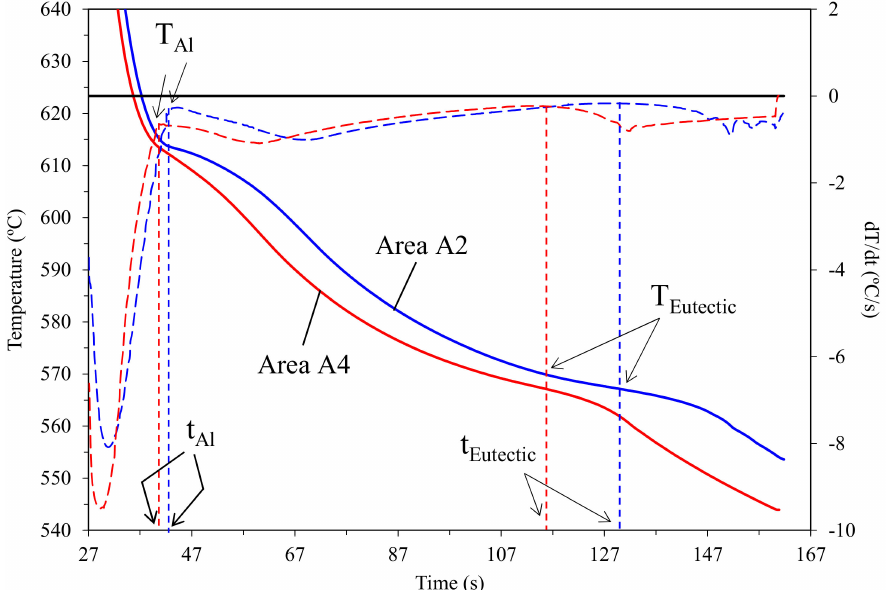
Figure 7. Characteristic solidification parameters in the simulated cooling curves (solid lines) obtained from areas A2 and A4 in casting SK-1. First derivative curves are plotted as interrupted lines.